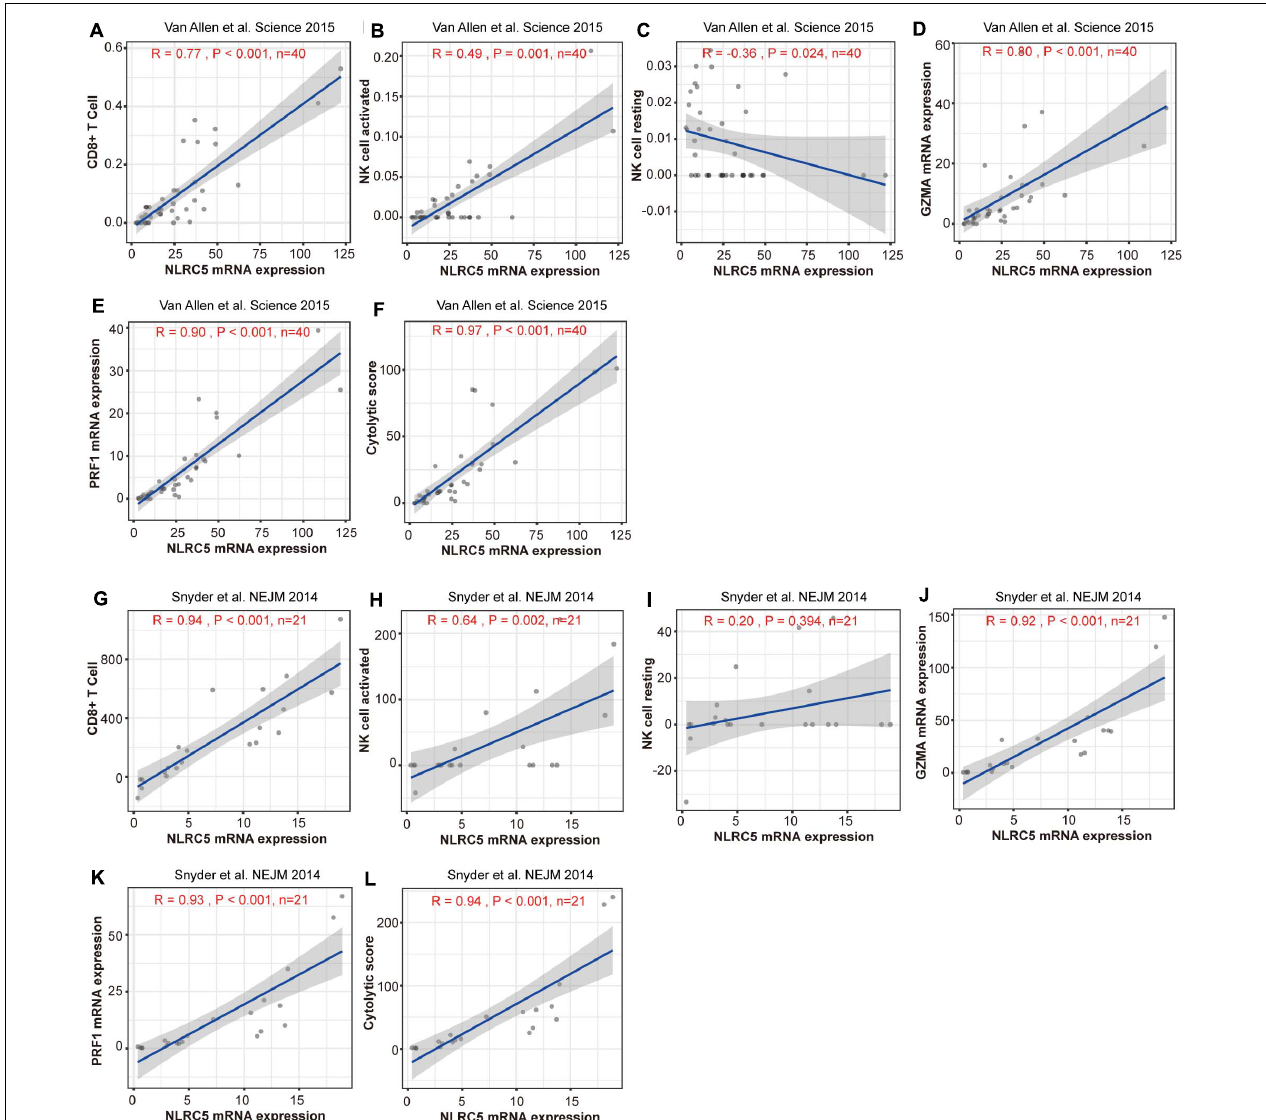
FIGURE 9 | Expression of NLRC5 and cytotoxic signature are positively correlated in melanoma patients receiving immunotherapy. (A,G) Spearman correlation analysis of the NLRC5 expression and infiltrating level of CD8 + T cells in “Snyder et al. NEJM 2014” and “Snyder et al., NEJM 2014” datasets, respectively. (B,H) Spearman correlation analysis of NLRC5 expression and infiltrating level of activated NK cells in “Snyder et al. NEJM 2014” and “Snyder et al., NEJM 2014” datasets, respectively. (C,I) Spearman correlation analysis of NLRC5 expression and infiltrating level of resting NK cells in “Snyder et al. NEJM 2014” and “Snyder et al., NEJM 2014” datasets, respectively. (D,J) Spearman correlation analysis of NLRC5 and GZMA expression in “Snyder et al. NEJM 2014” and “Snyder et al., NEJM 2014” datasets, respectively. (E,K) Spearman correlation analysis of NLRC5 and PRF1 expression in “Snyder et al. NEJM 2014” and “Snyder et al., NEJM 2014” datasets, respectively. (F,L) Spearman correlation analysis of the NLRC5 expression and cytotoxic score in “Snyder et al. NEJM 2014” and “Snyder et al., NEJM 2014” datasets,